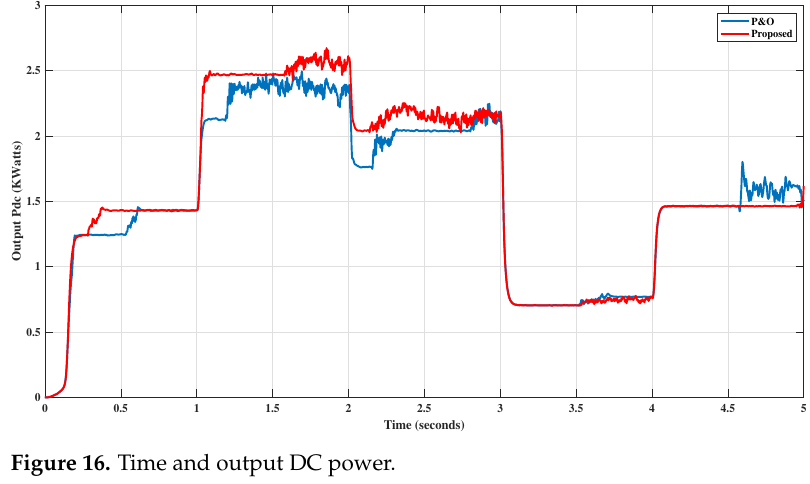
Figure 16. Time and output DC power.